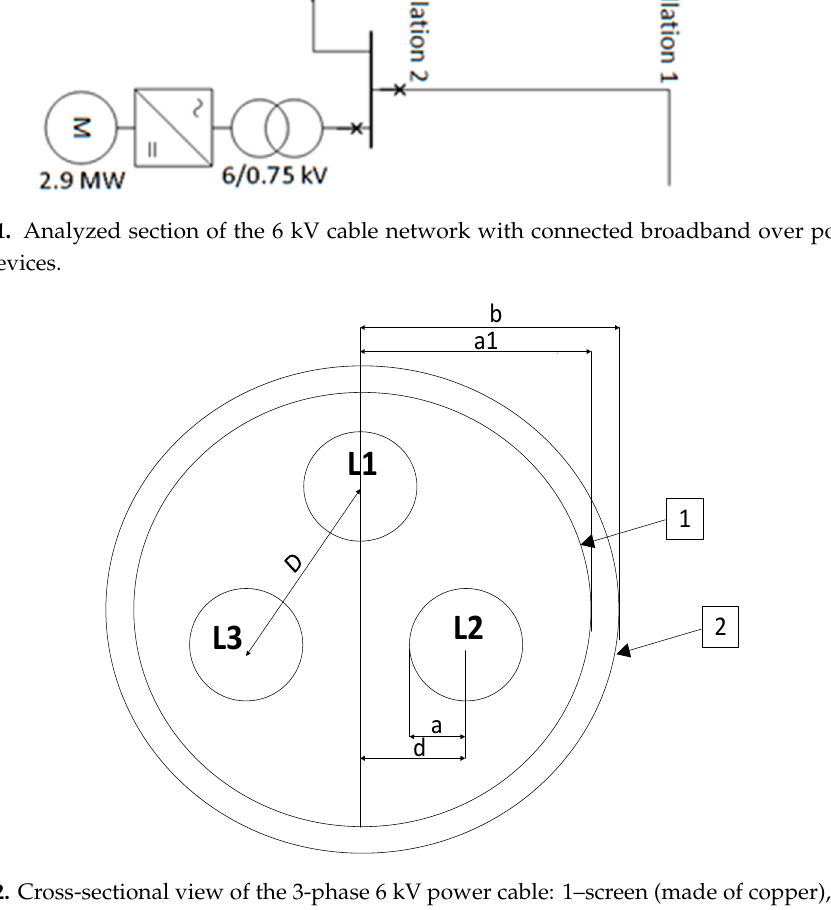
Figure 1. Analyzed section of the 6 kV cable network with connected broadband over power line (BPL) devices.